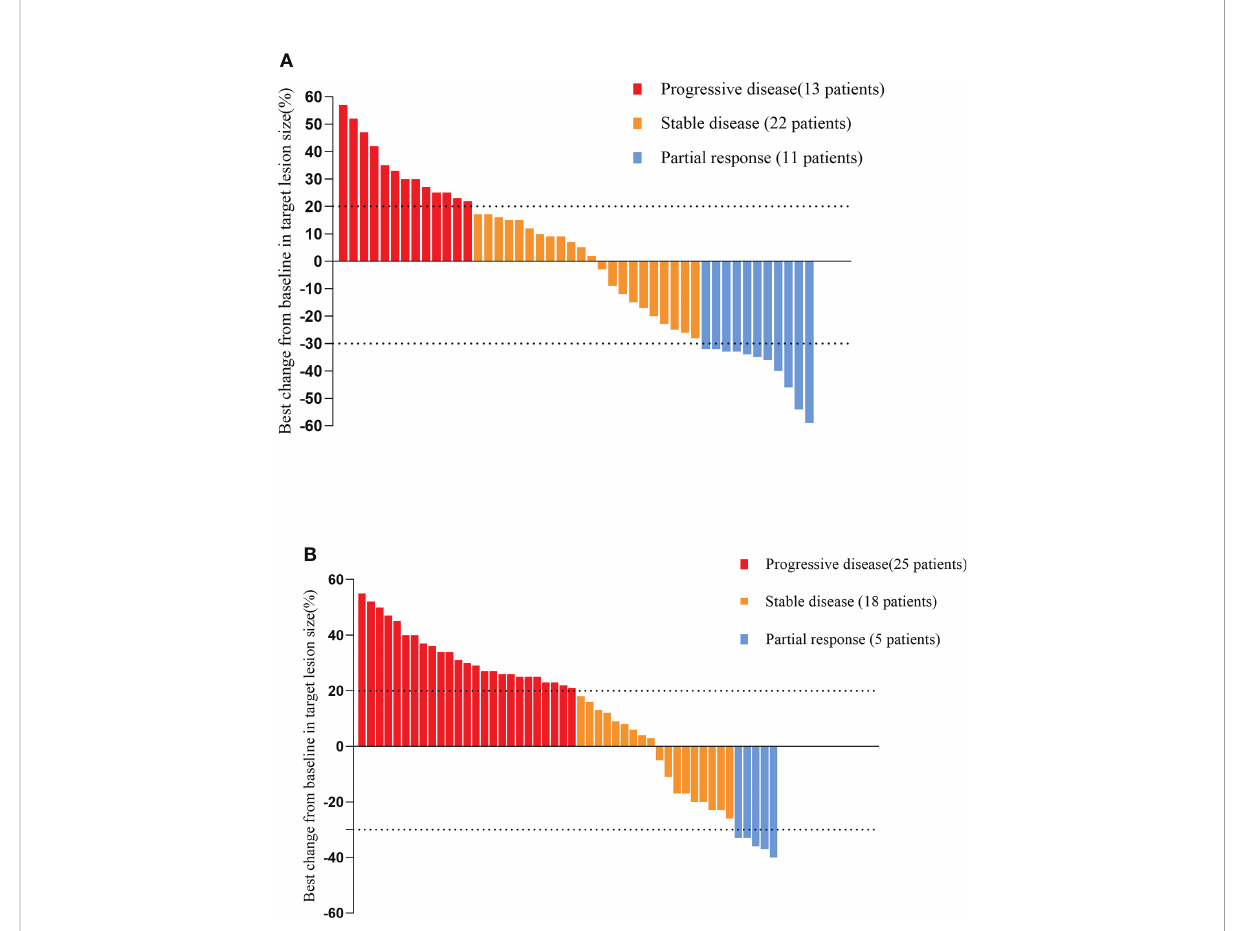
FIGURE 3 Waterfall plot illustrating maximum change in target lesion size based on the tumor response in patients treated with anlotinib plus PD-1 blockade (A) /anlotinib alone (B) . PD-1 blockade, Programmed death-1